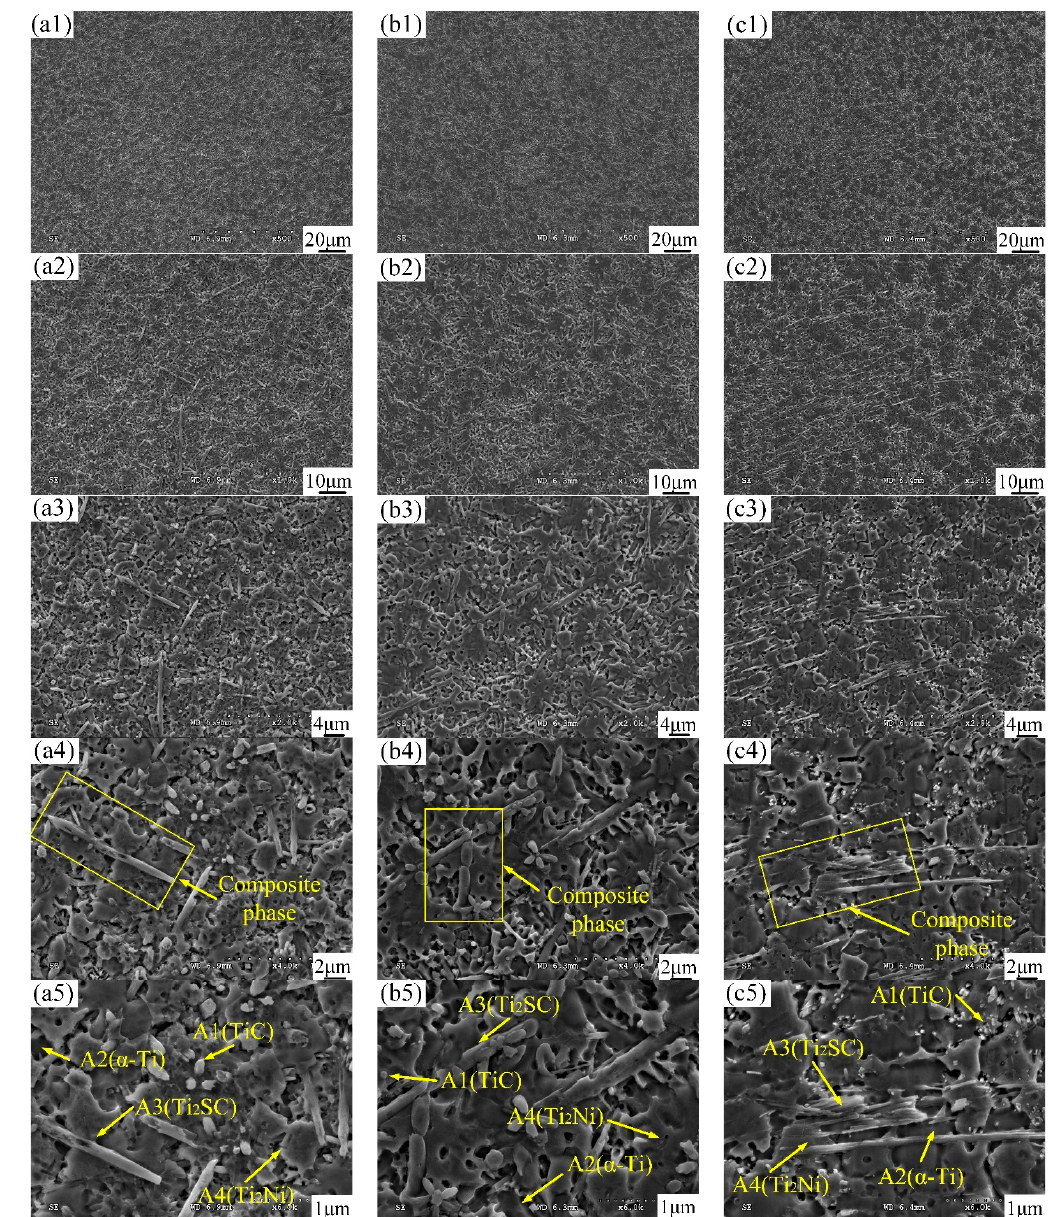
Figure 6. The SEM morphologies of the coating microstructure at different magnifications. ( a1 – a5 ) The 25 wt.% Ni-MoS 2 coating. ( b1 – b5 ) The 35 wt.% Ni-MoS 2 coating. ( c1 – c5 ) The 45 wt.% Ni-MoS 2 coating.